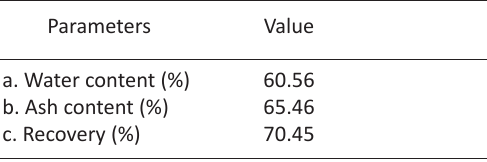
Table 1. Sulphated ash content analysis of the extracted